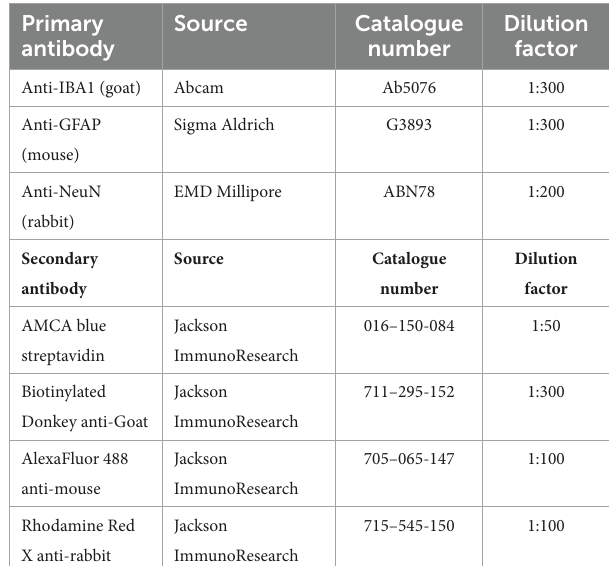
TABLE 2 Antibodies used for